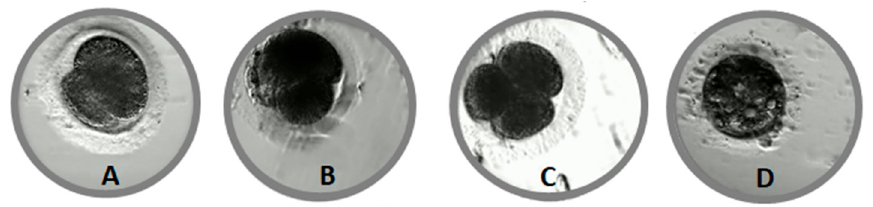
Figure 2. Morphological defects in cat embryos. ( A )—asymmetry of blastomeres, ( B )—cellular fragmentation, ( C )—direct cleavage, ( D )—vacuoles.